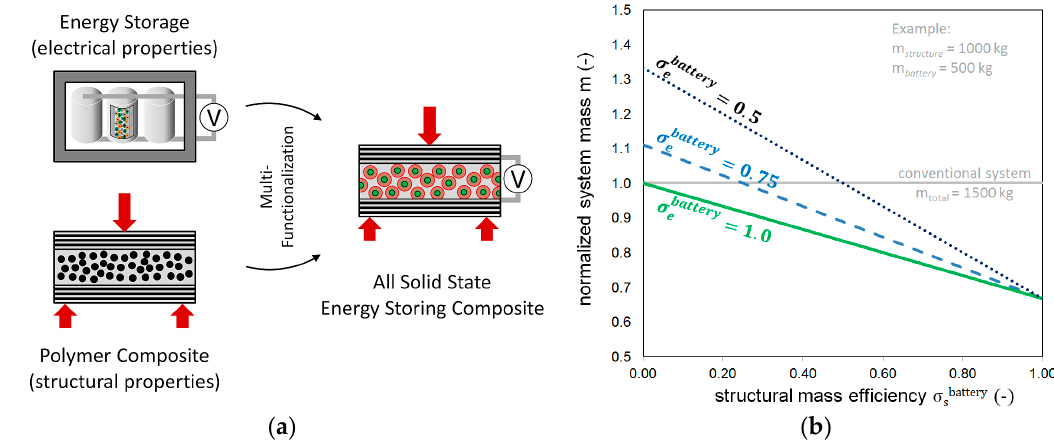
Figure 1. ( a ) Concept of multifunctional energy storing cross-ply composites with functionalized constituents; ( b ) calculated system mass reduction according to Wetzel [27].